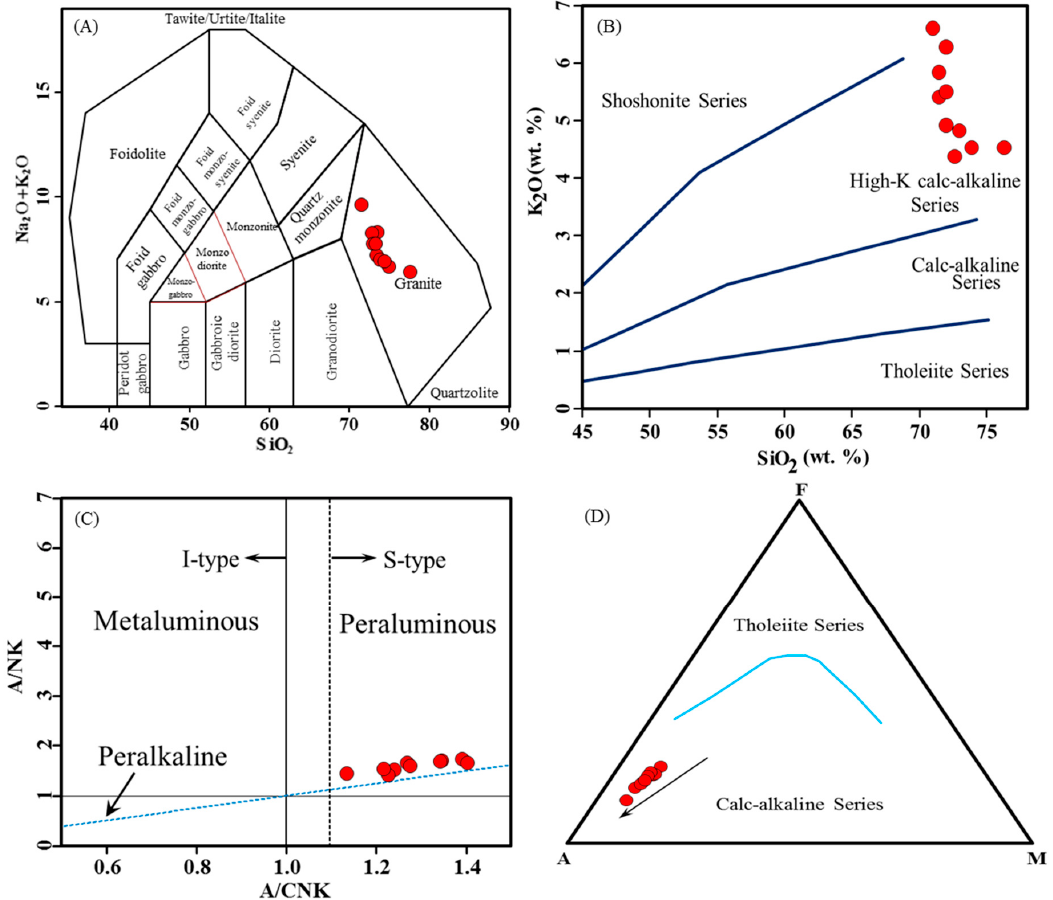
Figure 6. Oxide element geochemical data of granitic rocks from the Tagu area. ( A ). SiO 2 versus Na 2 O + K 2 O binary diagram shows that the majority of samples fell in the granitoid field [27]; ( B ). K 2 O wt.% versus SiO 2 wt.%; the subdivisions are by [28]; ( C ). Alumina saturation index diagram: The A / CNK (molar Al 2 O 3 / (CaO + Na 2 O + K 2 O)) ratio is greater than 1.1 and it can be assumed that the granite is